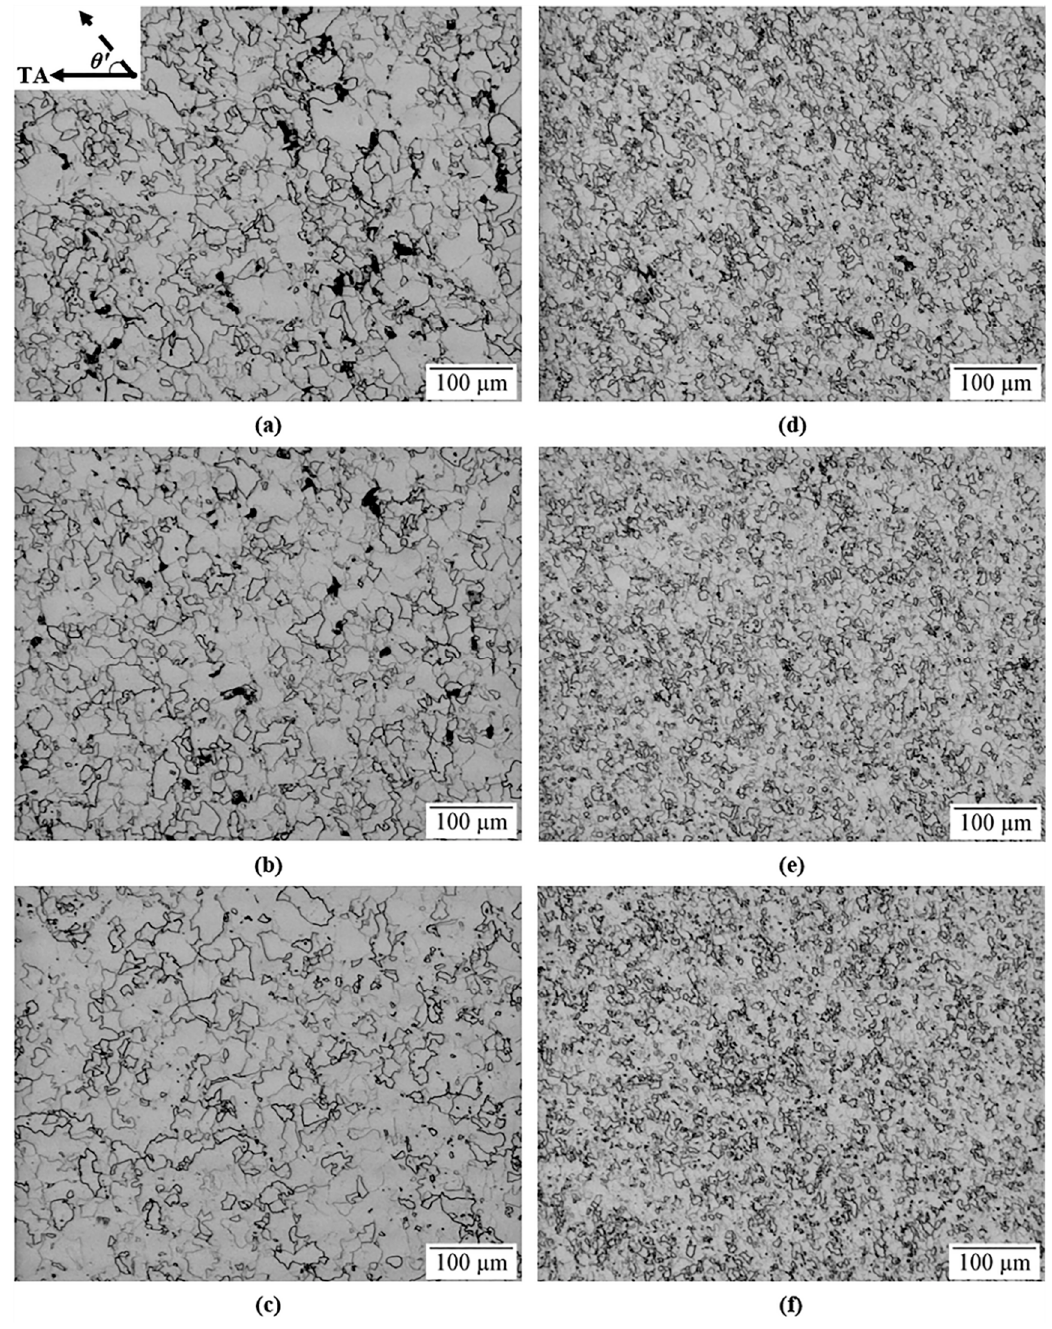
Figure 14. LOM micrographs of the polygonal ferrite microstructures produced via ( a – c ) High T Finish and ( d – f ) Low T Finish simulations followed by isothermal holding at 650 °C for 30 min. The following radial positions are shown: ( a ) and ( d ) 0.50; ( b ) and ( e ) 0.724; and ( c ) and ( f ) 0.90. The torsional axis (TA) is horizontal to the page. Etched with 1 pct nital.